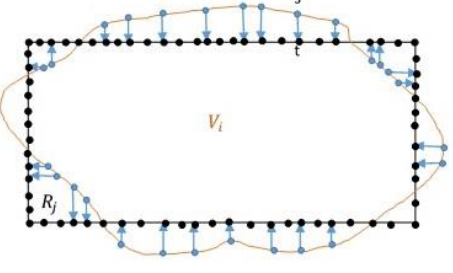
Fig. 4 Boundary distance between 𝑉 𝑖 and 𝑅 𝑗